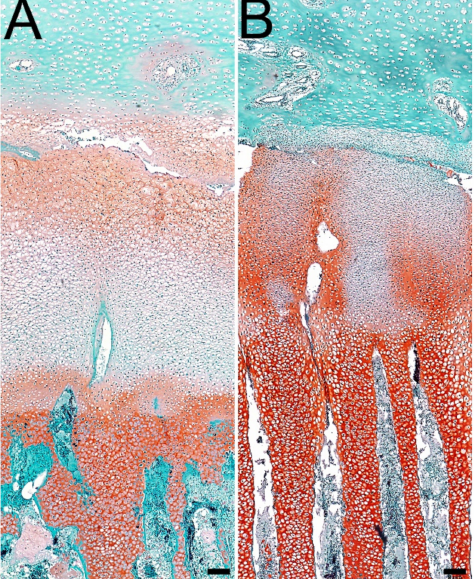
Figure 4. Representative photos of Safranine O staining carried out on formaldehyde-fixed sections from the growth plate cartilage of tibia of animals at 42 days of age. Control group ( A ); experimental group ( B ). Differences were observed in proteoglycan staining in tibial growth plate cartilage. Staining with Safranin O indicates the presence of proteoglycans, the red color in the matrix. All the scale bars represent 8 µ